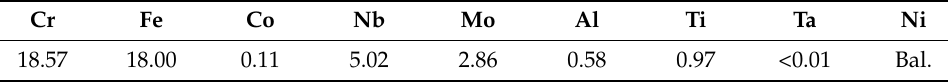
Table 1. The chemical composition of IN718 alloy (in